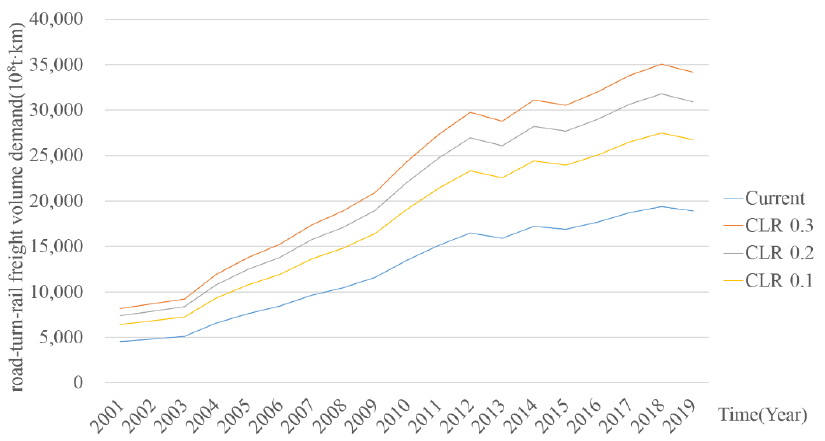
Figure 6. Road-to-rail freight volume demand with different carbon levy rates.